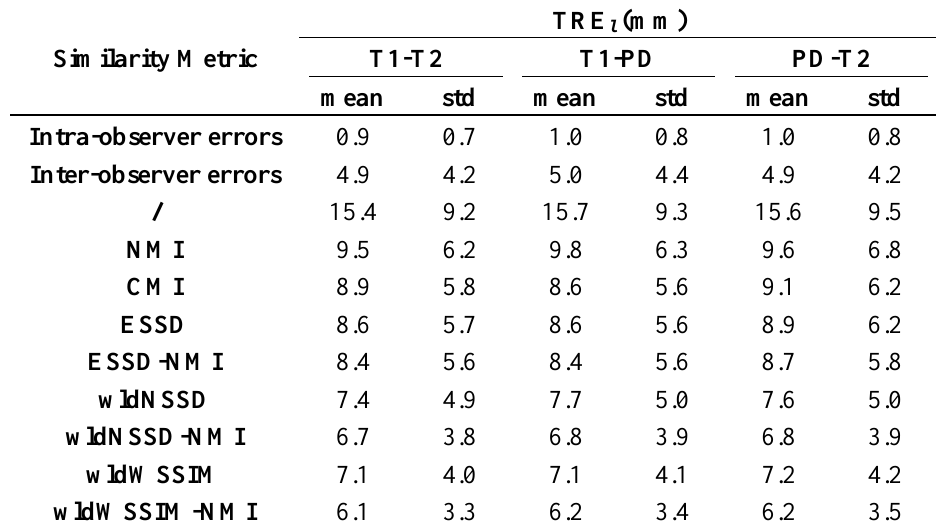
Table 2. (in mm) for all the evaluated methods.